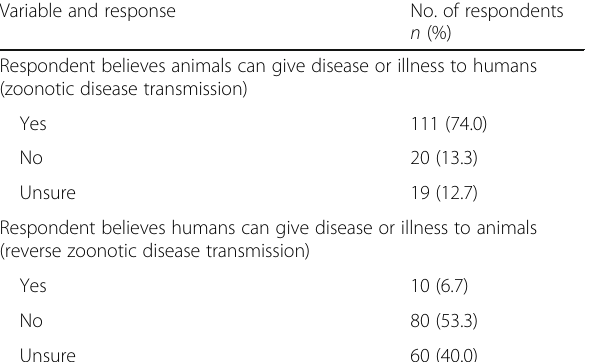
Table 4 Zoonotic knowledge and risk perception reported in Mongolian herding households ( n = 150) Variable and